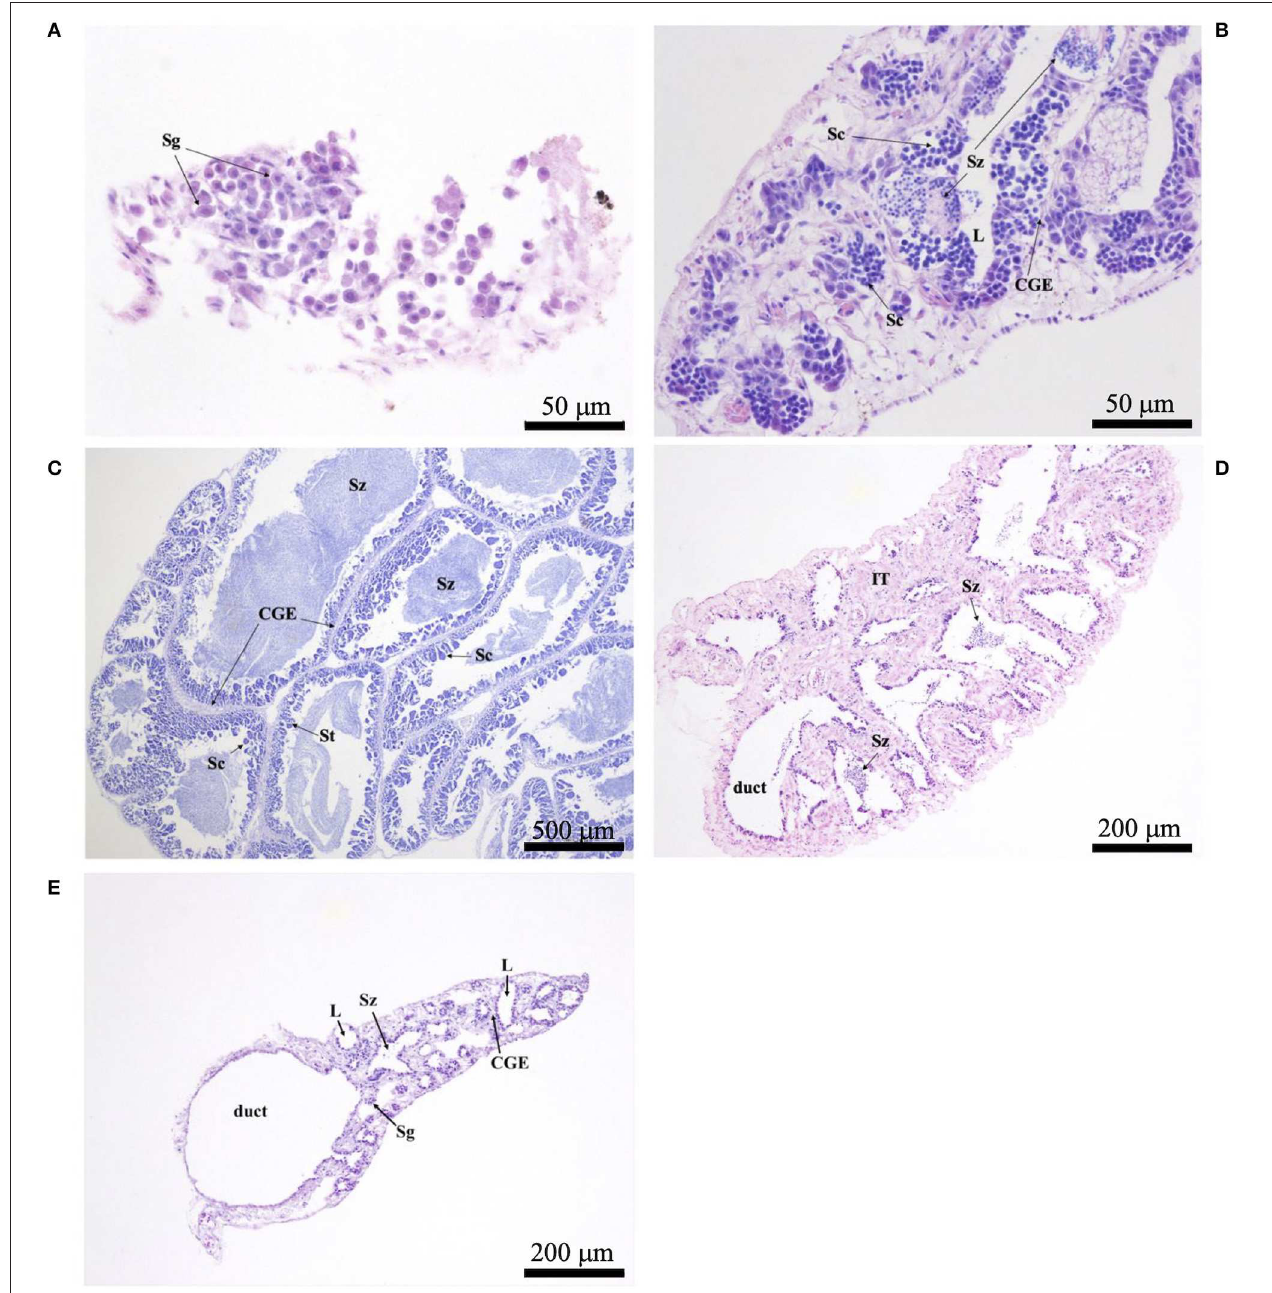
FIGURE 2 | Photomicrographs of testicular histology, depicting: (A) Astronesthes atlanticus in the immature phase, with only spermatogonia (Sg) in the testes; scale bar = 50 µ m; (B) Melanostomias melanops in the developing phase, with spermatocysts of spermatocytes (Sc), and cysts of spermatozoa (Sz) that have not yet entered the lobular lumina (L). Continuous germinal epithelium (CGE) present; scale bar = 50 µ m; (C) peripheral tissue of Echiostoma barbatum in the spawning capable phase, with Sc, spermatids (St), Sz, and CGE; scale bar = 500 µ m; (D) Melanostomias melanops in the regressing phase, with residual Sz in the lumina and duct; note the expanded interstitial (connective) tissue (IT); scale bar = 200 µ m; (E) Echiostoma barbatum in the regenerating phase, with residual Sz in some lobules, empty lumina (L), CGE, and Sg proliferation; scale bar = 200 µ m.